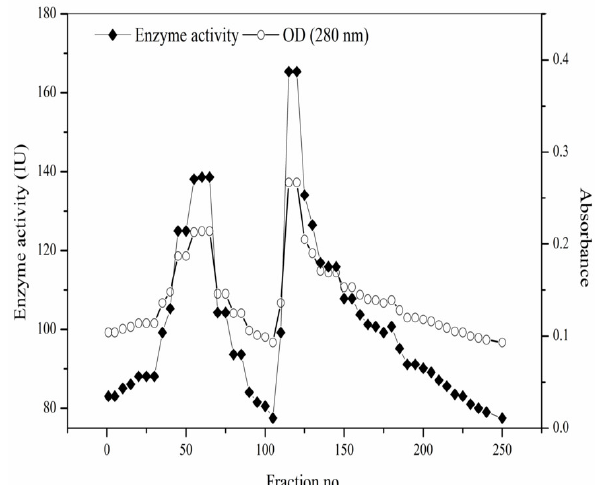
Fig. 2. Profile of the elution of starch hydrolyzing activity of Bacillus amyloliquefaciens MCCB0075 by the DEAE-cellulose gel filtration column. Symbols: c ircle ( ○ ) absorbance at 280 nm; black filled square ( ♦ ) amylolytic activity. Enzymatic activity was quantified based on the amount of reducing sugar (DNS) using starch as substrate Tab. 2. Summary of purification steps of the α -amylase from Bacillus amyloliquefaciens through wheat and barley mix (1:1)